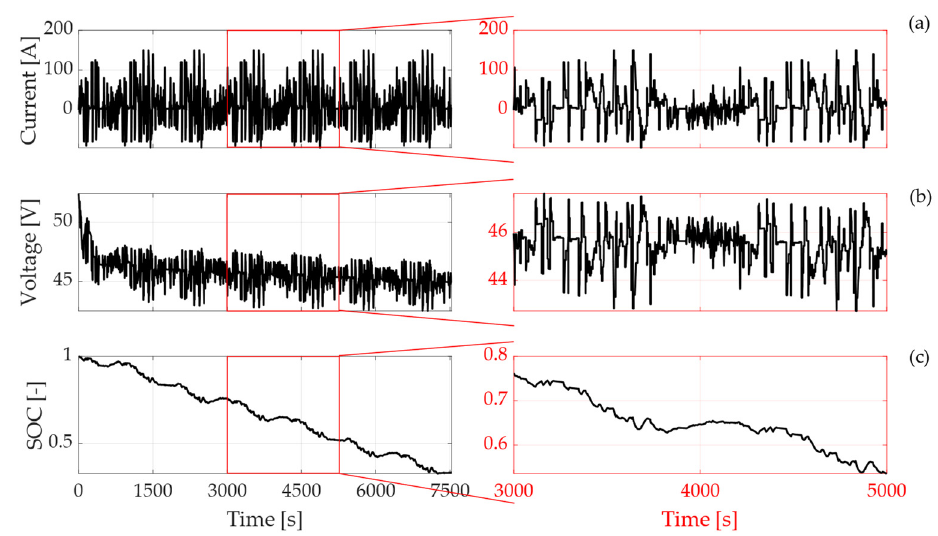
Figure 7. Training dataset for NARX RNN — layout 1: ( a ) current, ( b ) voltage, ( c ) SOC.